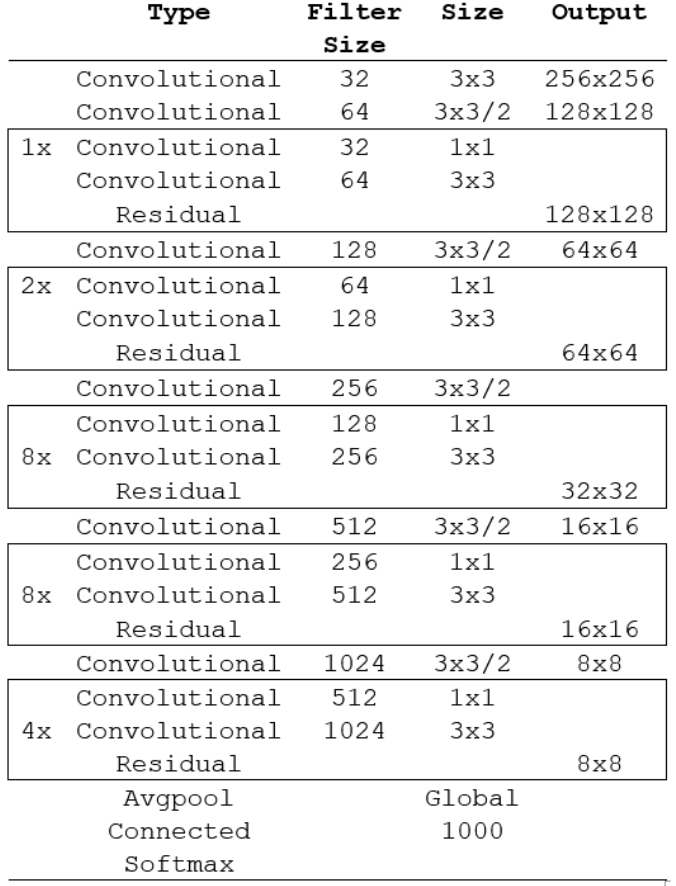
Figure 1. Darknet-53 Structure.